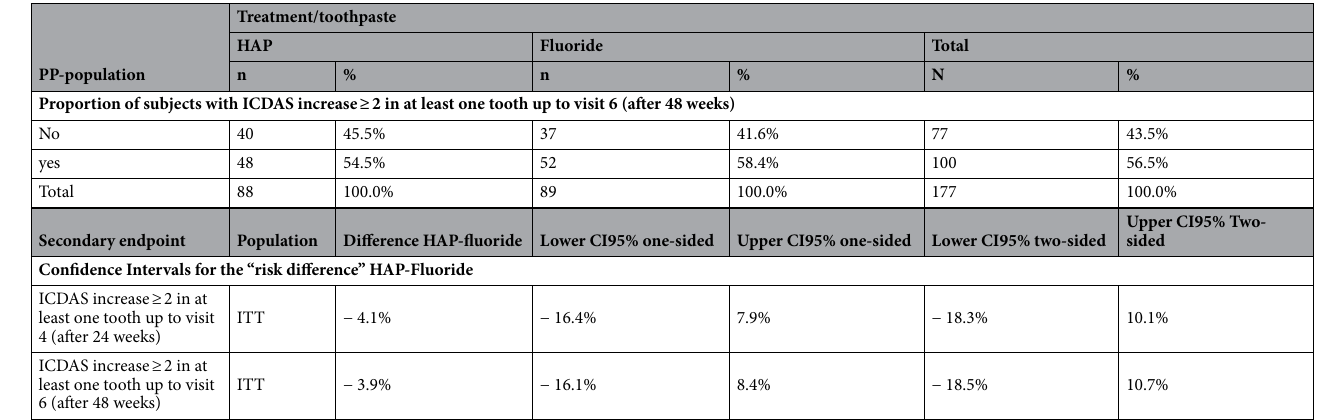
Table 4. Development of at least one enamel caries lesions with ICDAS code ≥ 2 in the